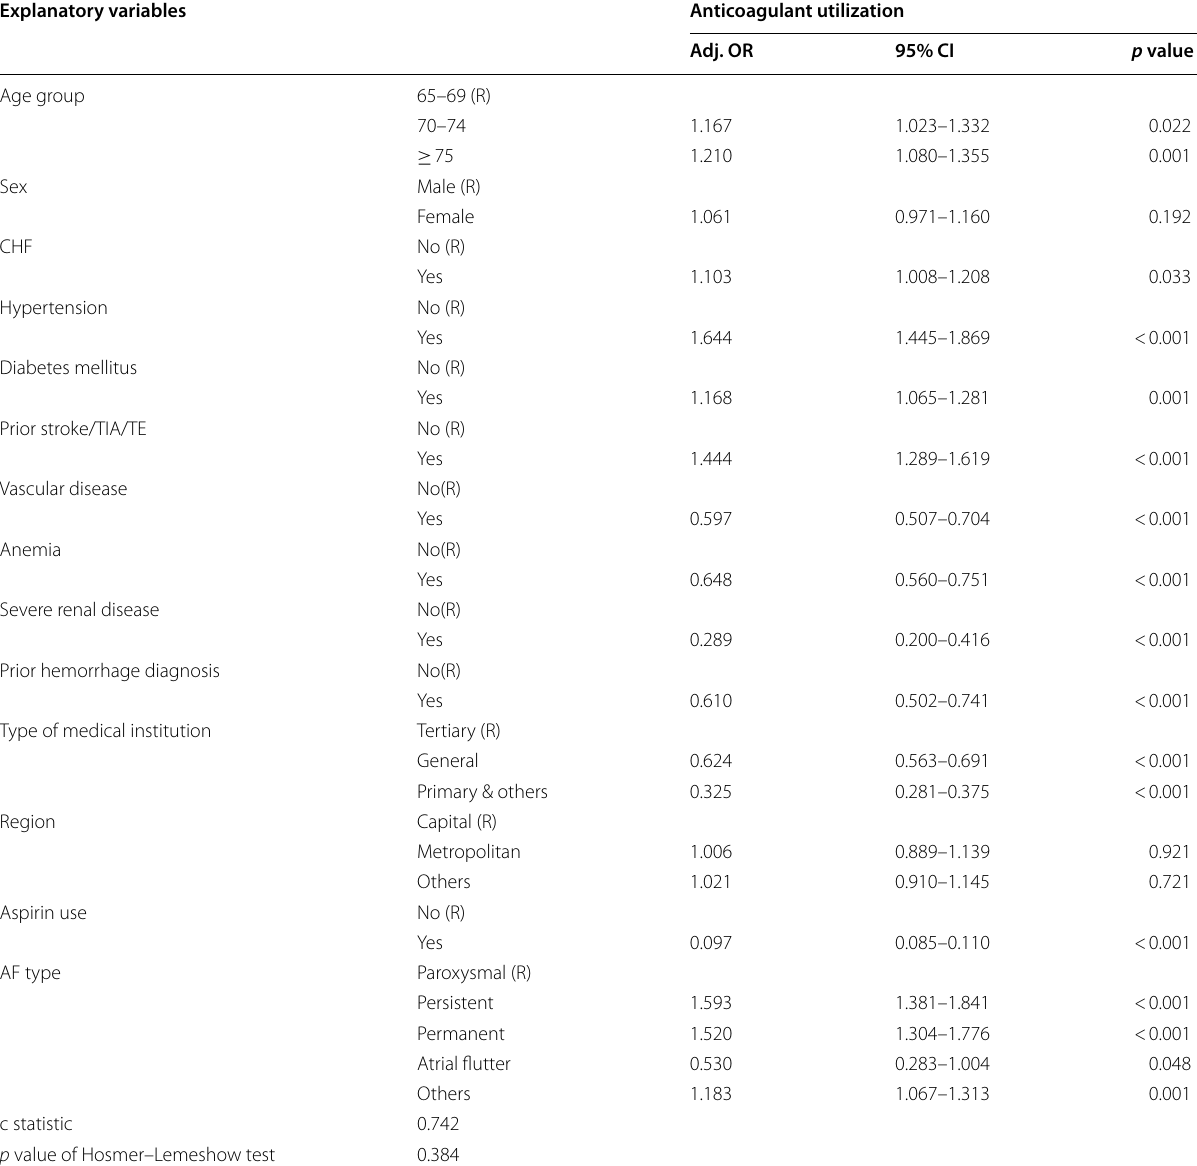
Table 2 Adjusted odds ratios and 95% confidence intervals from the multiple logistic regression analysis of anticoagulant utilization